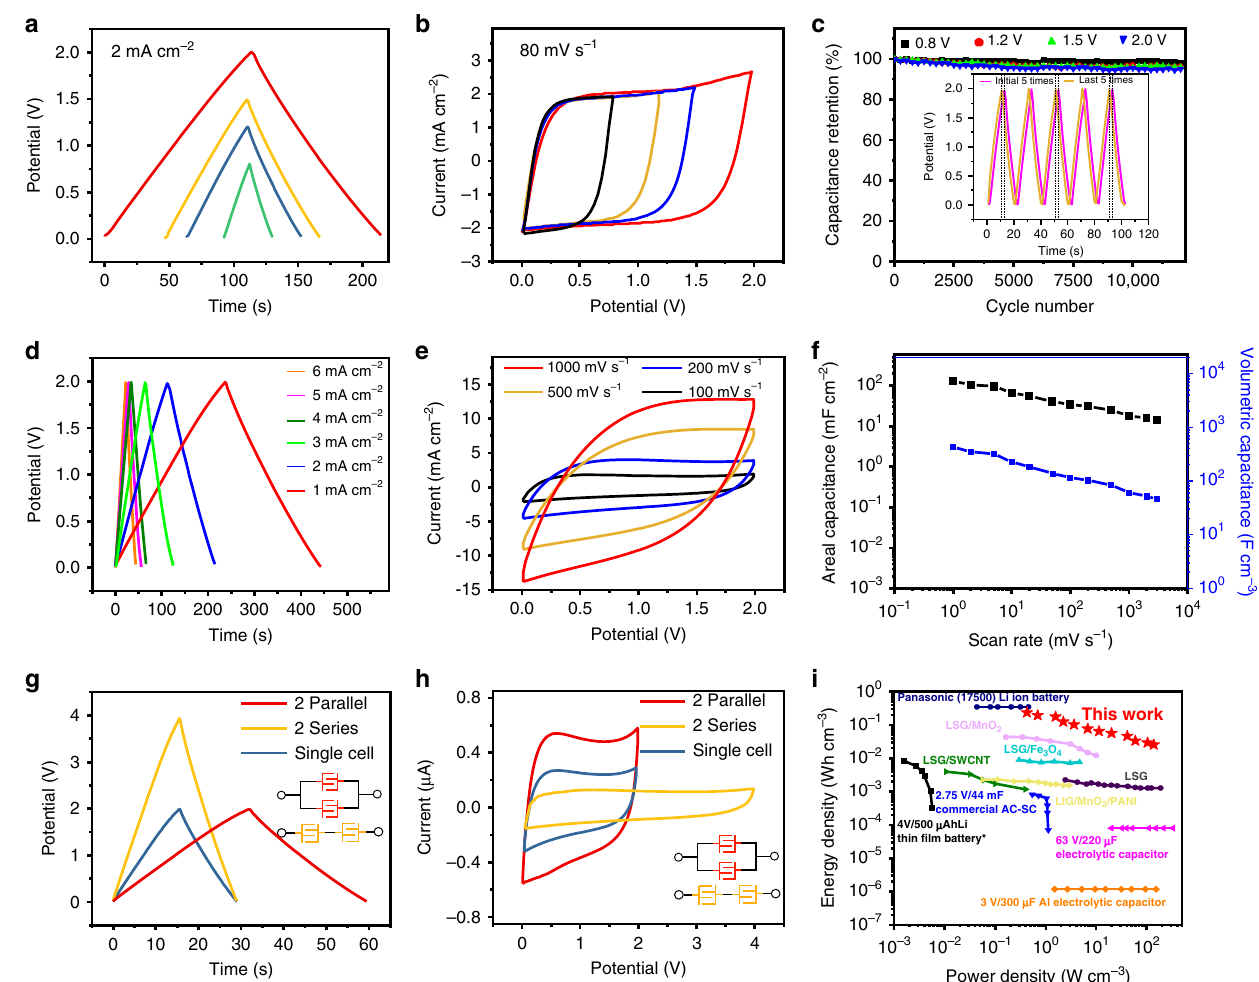
Fig. 5 Electrochemical performances of interdigital MSCs. a GCD pro fi les of LIG/MnO 2 MSCs in 0.5 M Na 2 SO 4 with different operating voltages from 0.8 to 2 V at 2 mA cm − 2 . b CV curves of LIG/MnO 2 MSCs in 0.5 M Na 2 SO 4 with different operating voltages from 0.8 to 2 V at a scanning rate of 80 mV s − 1 . c Cycle life of the MSCs under different voltage windows. Inset: fi ve GCD curves of interdigital MSCs before and after 12,000 cycles under the voltage windows of 2 V. d The GCD pro fi les of interdigital MSCs at current density from 1 to 6 mA cm − 2 under 2 V voltage window. e CV curves of interdigital MSCs at scan rates ranging from 100 to 1000 mV s − 1 under 2 V voltage windows in 0.5 M Na 2 SO 4 . f The areal capacitance and volumetric capacitance under different scan rates. g GCD pro fi les of a single device, two devices in parallel and two devices in series. h CV curves of a single device, two devices in parallel and two devices in series. i Energy and power densities of the LIG/MnO 2 MSCs compared with other capacitors and